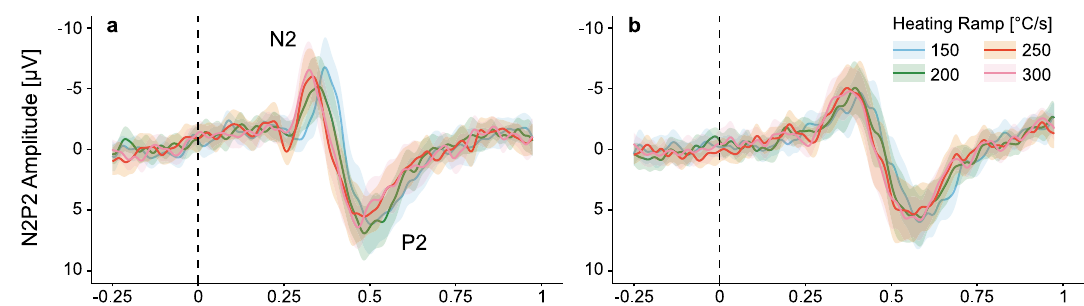
Figure 3. Grand averages of contact heat evoked potential (CHEP) when stimulating with the ( a ) hand, and ( b ) foot. Illustrated is the group average when stimulating with 150 °C/s (blue), 200 °C/s (green), 250 °C/s (orange), and 300 °C/s (pink) as well as the 95% confidence